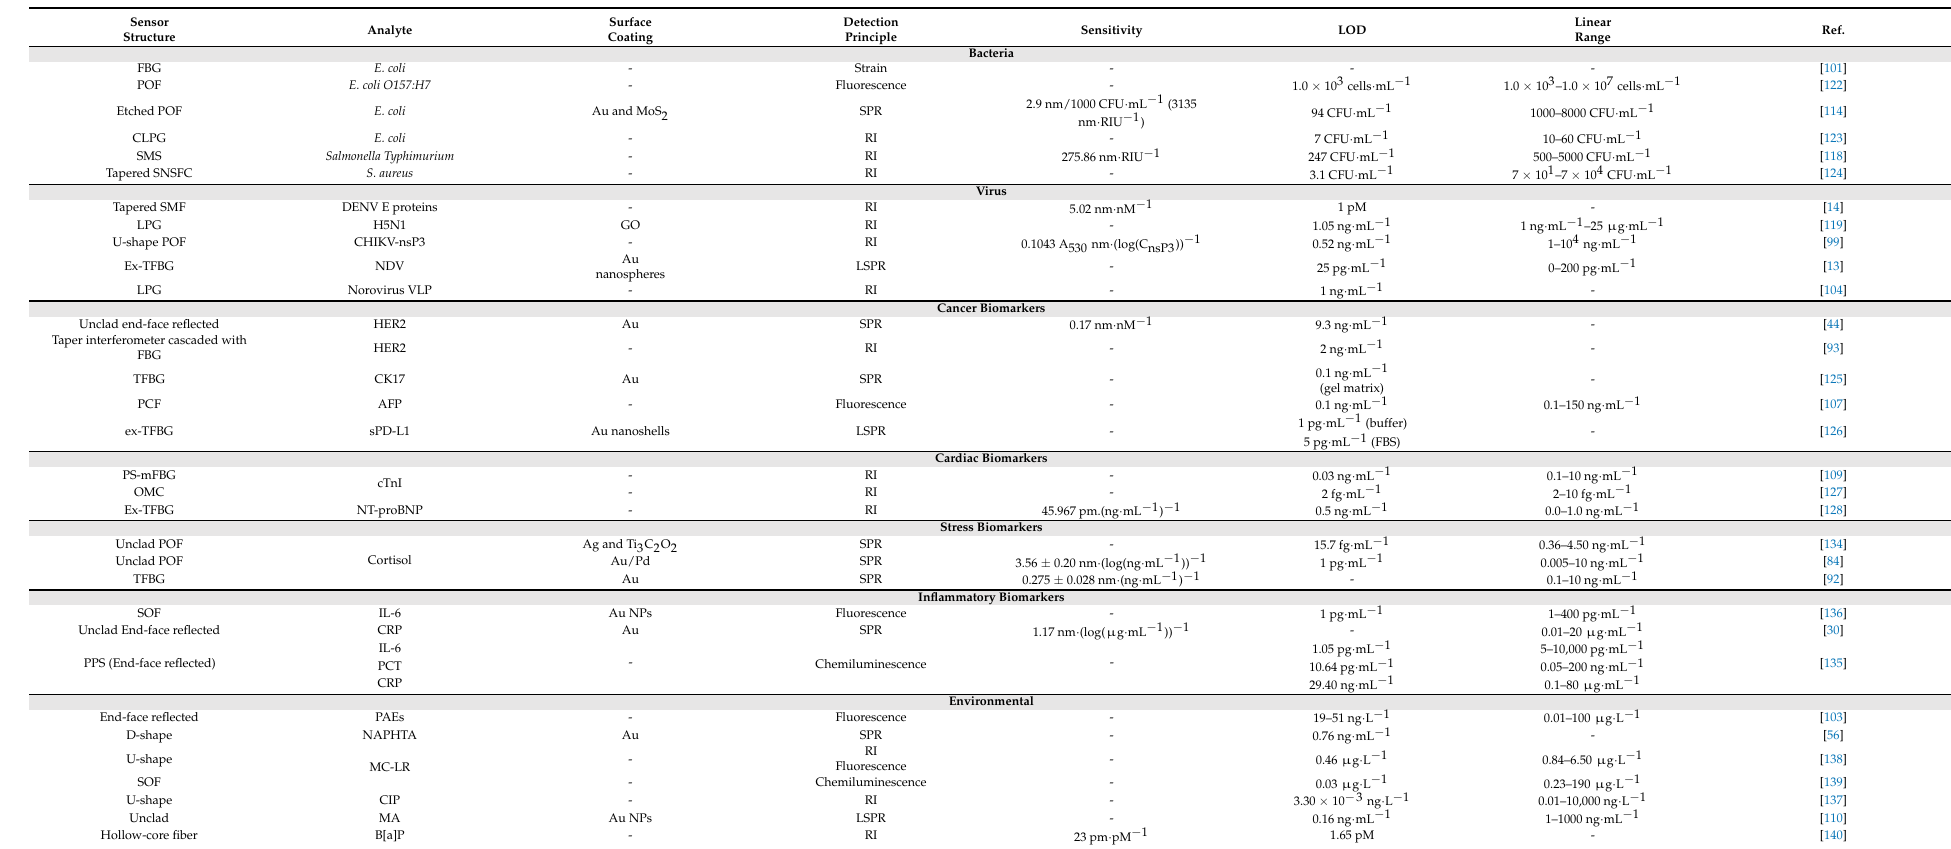
Table 2. Performance parameters and characteristics of state-of-the-art